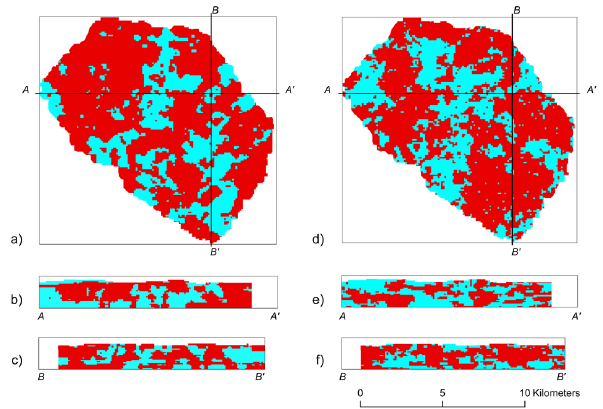
Fig. 4. 3-D training image (left) and an example of a geological realization (right). Red and blue indicate Quaternary sand and clay, respectively. (a) Horizontal view of 3-D training image at elevation of − 10ma.s.l.; (b) X-Z cross section of 3-D TI with Z exaggeration of 15; (c) Y-Z cross section of 3-D TI with Z exaggeration of 15; (d) horizontal view of realization at elevation of − 10ma.s.l.; (e) X-Z cross section of realization with Z exaggeration of 15; (f) Y-Z cross section of realization with Z exaggeration of 15.